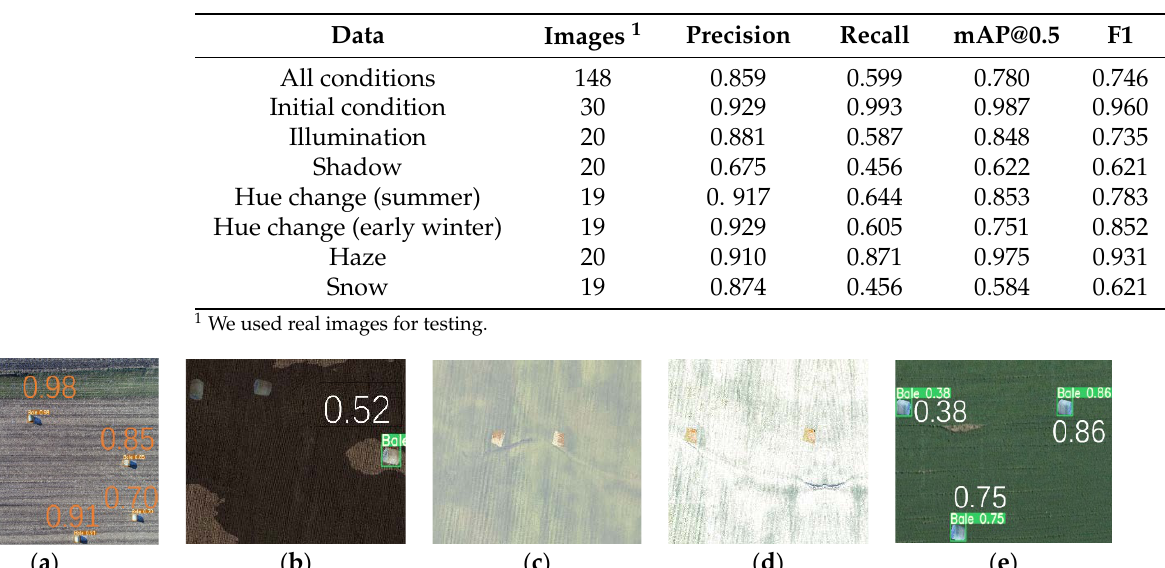
Table 3. YOLOv3 model (trained in Step 1) performance for detecting bales in different conditions without being trained with synthetic images.